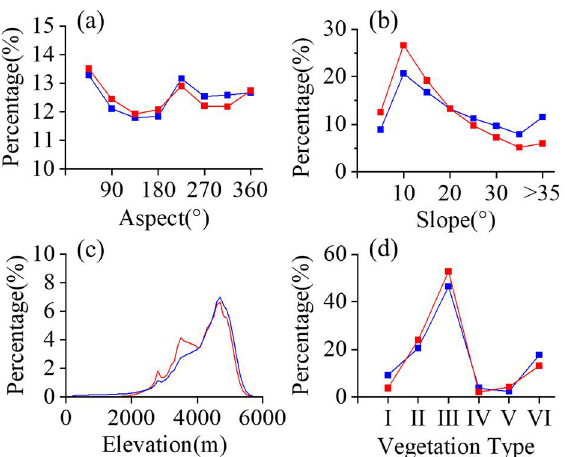
Figure 11. The percentage of the study area (red line) and reference vegetation area (blue line) corresponding to different aspects ( a ), slopes ( b ), altitudes ( c ), and vegetation types ( d ). The codes used for the vegetation types in ( d ) are the same as those in Figure 1.